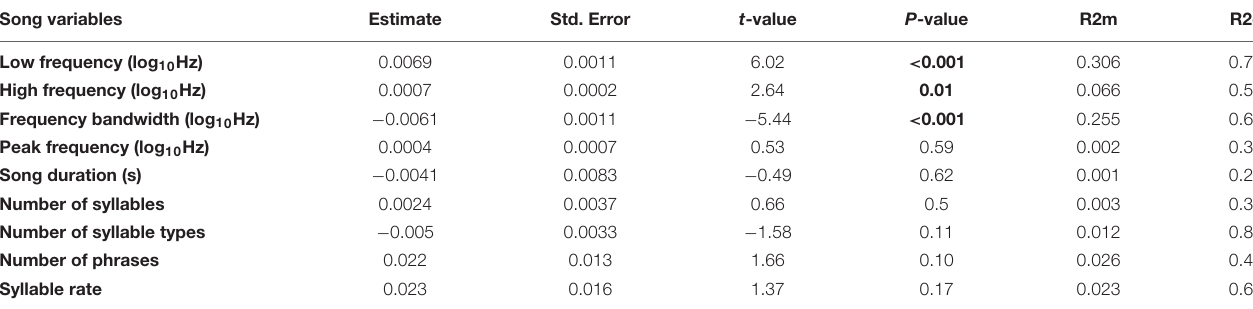
TABLE 1 | Fitted linear mixed models of the spectral or temporal or elaboration song variables on the noise level. Song variables Estimate